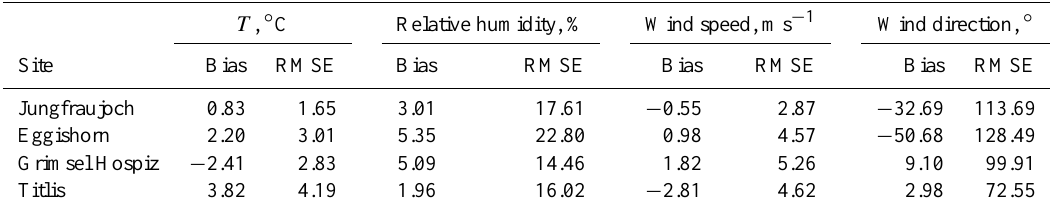
Figure 2. A comparison of the air temperature at four MeteoSwiss observation stations with the WRF control simulation during the INUPIAQ field campaign. Table 3. Bias and root mean square error of temperature, relative humidity, wind speed and wind direction between the WRF control simulation and measurements taken at four MeteoSwiss